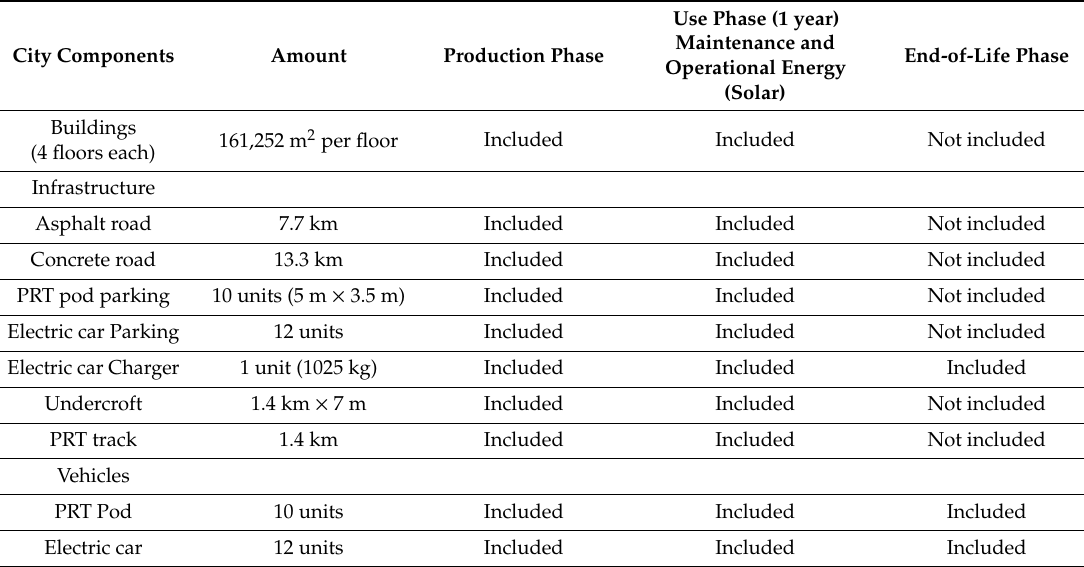
Table 3. Products systems used for